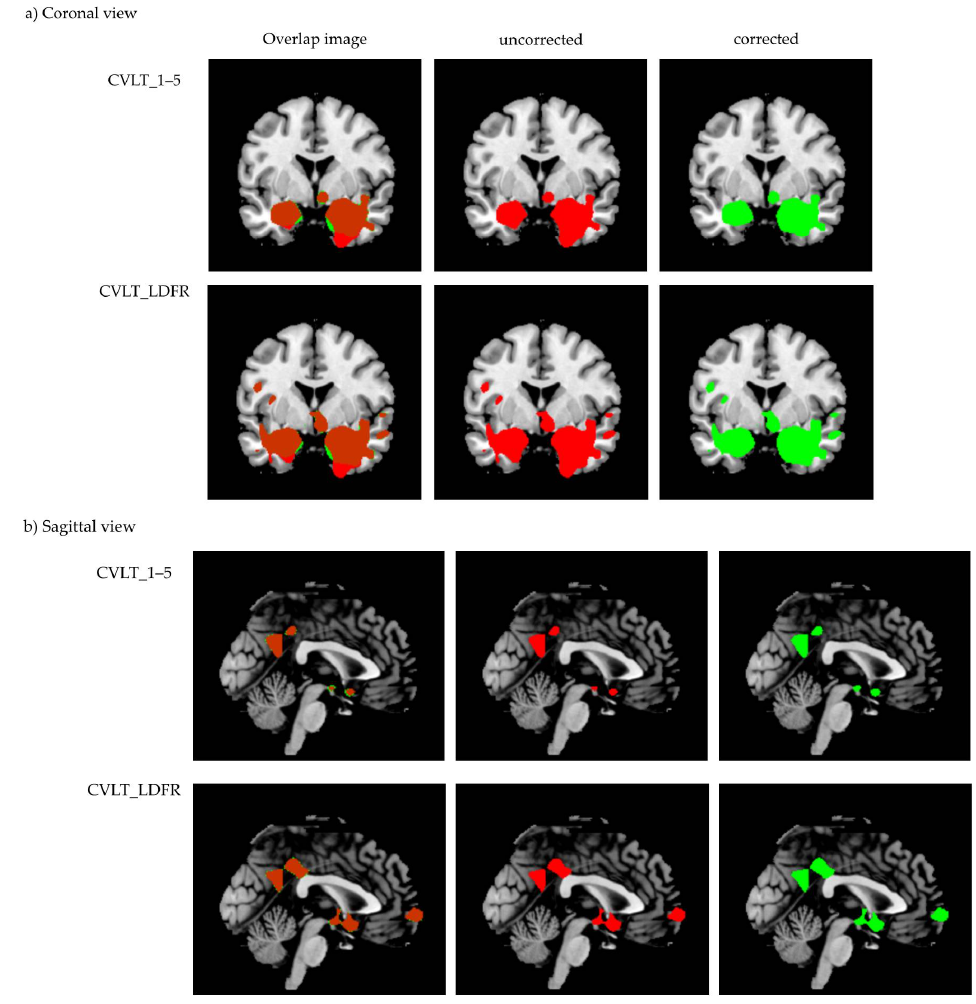
Figure 4. Comparison of voxel-based morphometry results for ( a ) coronal view and ( b ) sagittal view generated in MRIcron. Displayed is the overlap image, as well as separate images for the corrected (green) and uncorrected (red) data.